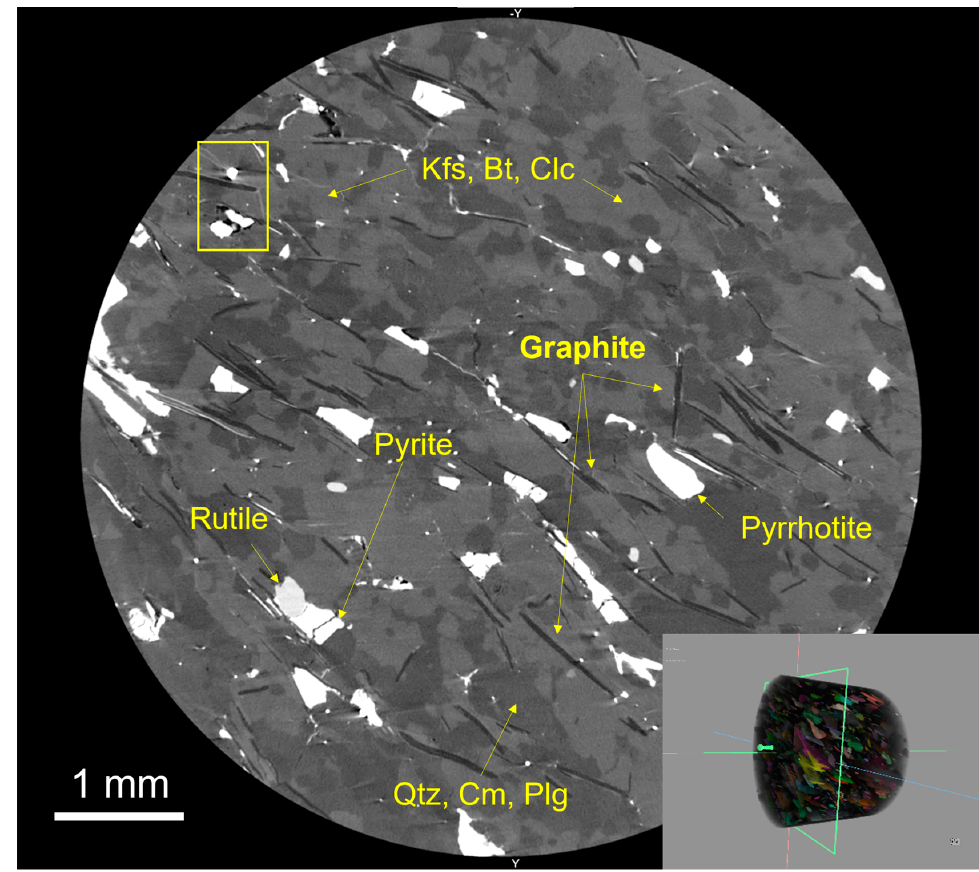
Figure 5. CT volume slice of the cylindrical subvolume of the scanned graphite sample. Note the imaging artefacts in the yellow framed box (bright shining streaks above a graphite flake and dark areas between and around two Po crystals) due to the highly X-ray absorbing iron phases present in the sample. Abbreviations: Qtz = quartz, Bt = biotite, Kfs = alkali feldspar, Plg = plagioclase, Clc = clinochlore, Cm = clay minerals.